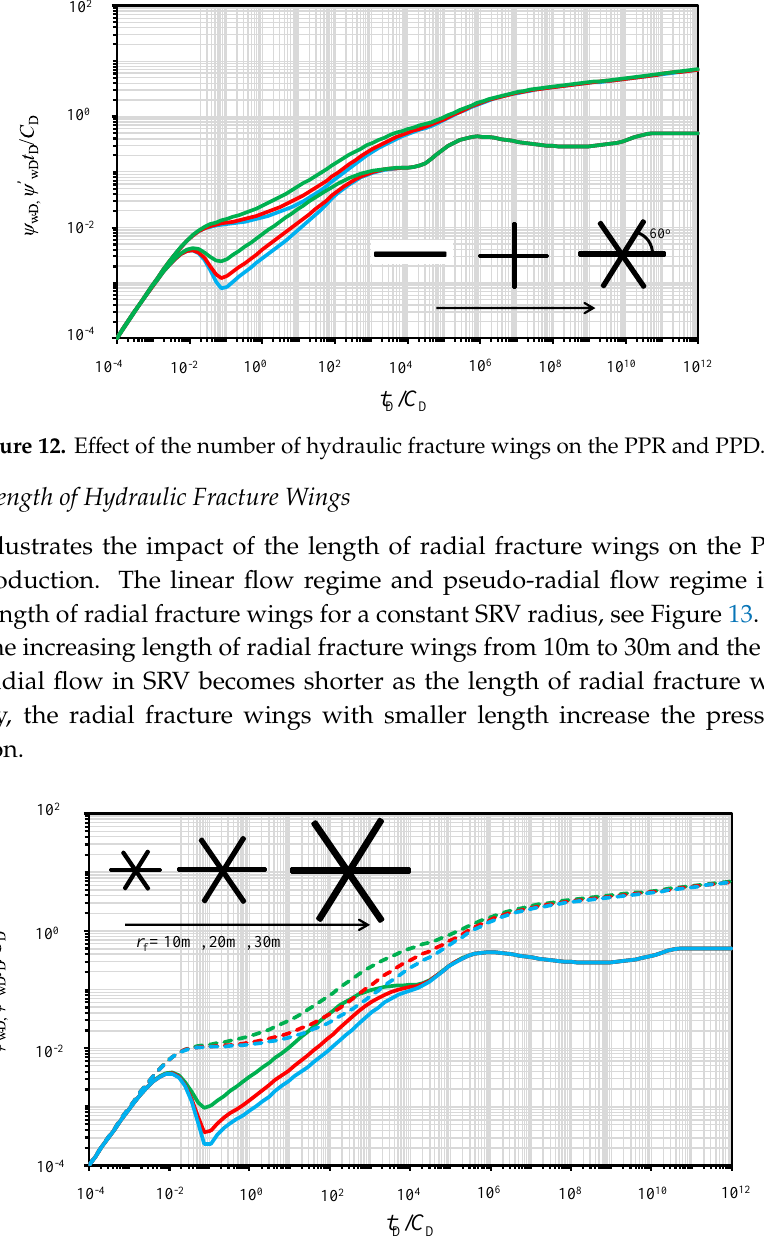
Figure 13. Effect of the length of hydraulic fracture wings on the PPR and PPD.